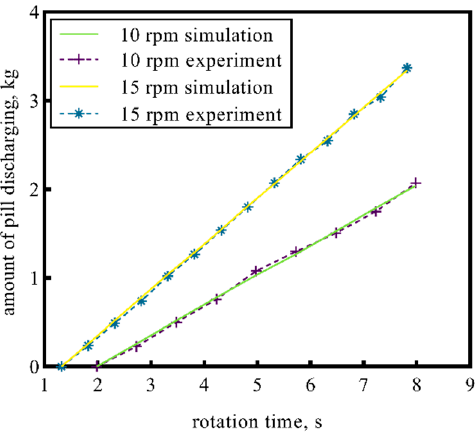
Figure 3. Experiment data and simulation results of the parameter validation.